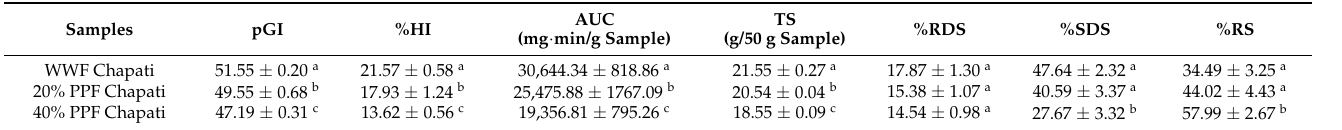
Table 3. Predicted glycemic index (pGI), hydrolysis index (HI), glucose area under the curve (AUC), and starch fractions of chapati